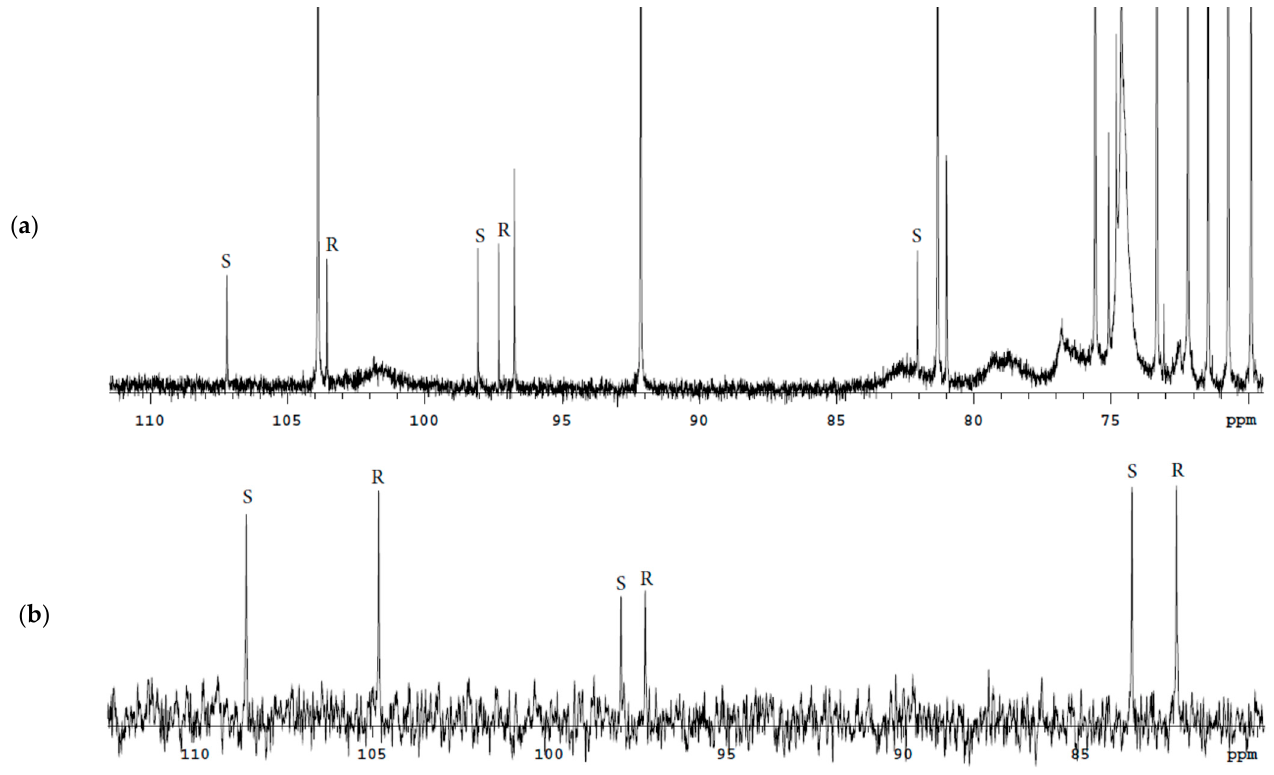
Figure 9. 1 H spectra fragments of the Bud tablets solutions in DMSO-d6 ( а ) and CDCl 3 ( b ) with characteristic signals of 22 R and 22 S epimers.